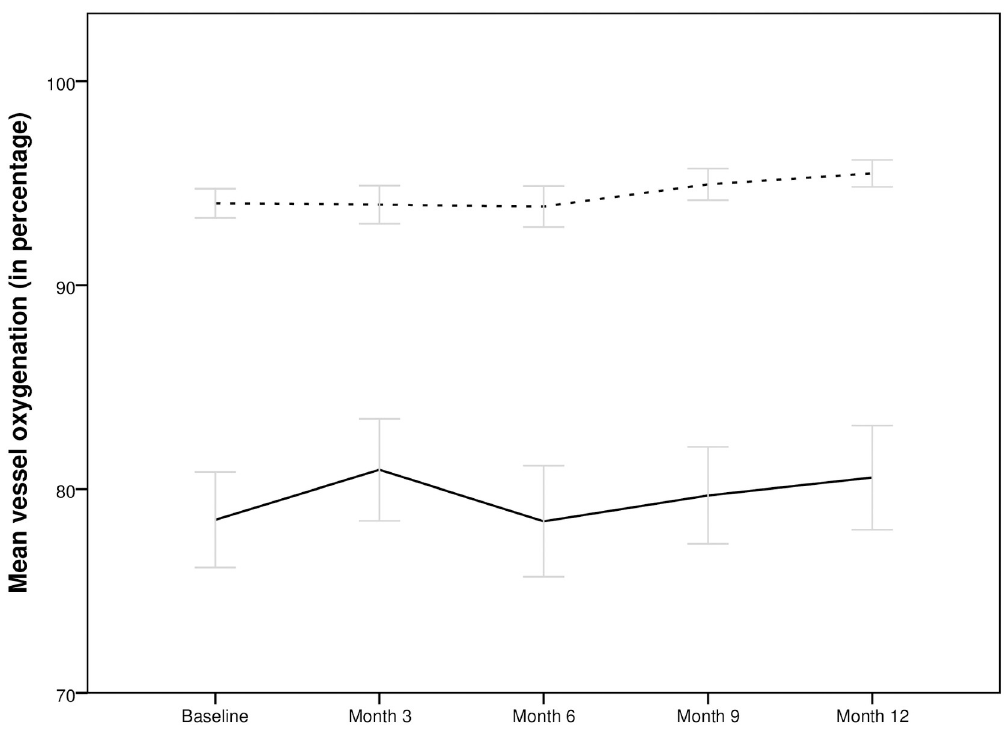
Fig 2. Course of arterial (dotted line) and venous (continuous line) vessel oxygen saturation of the total population during the treatment with aflibercept. No significant change was observed over the 12 months period.